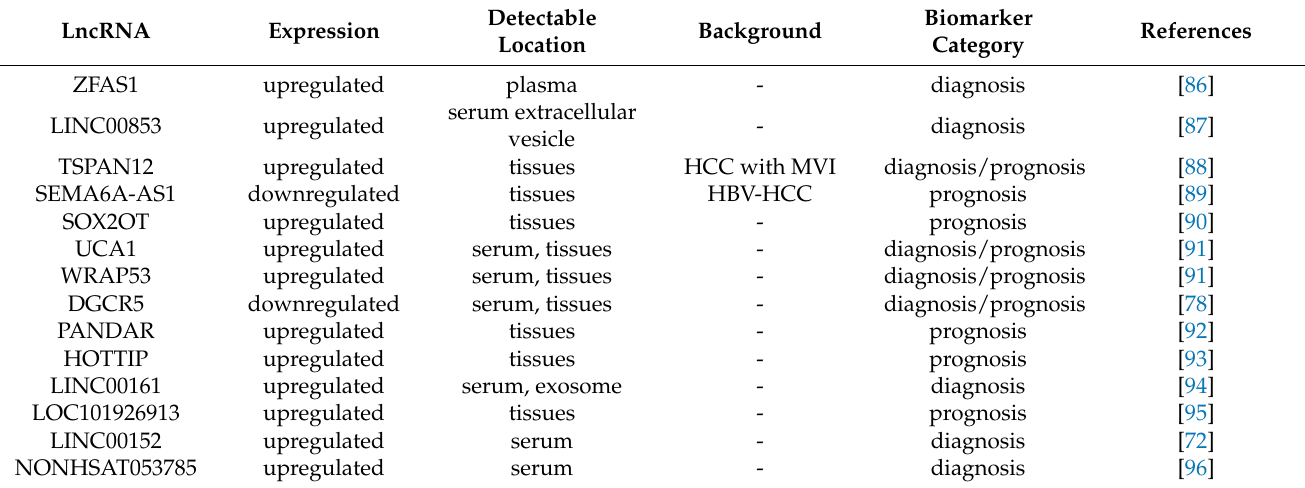
Table 2. Recent studies on the expression levels of potential lncRNA-based biomarkers in hepatocellular carcinoma. LncRNA